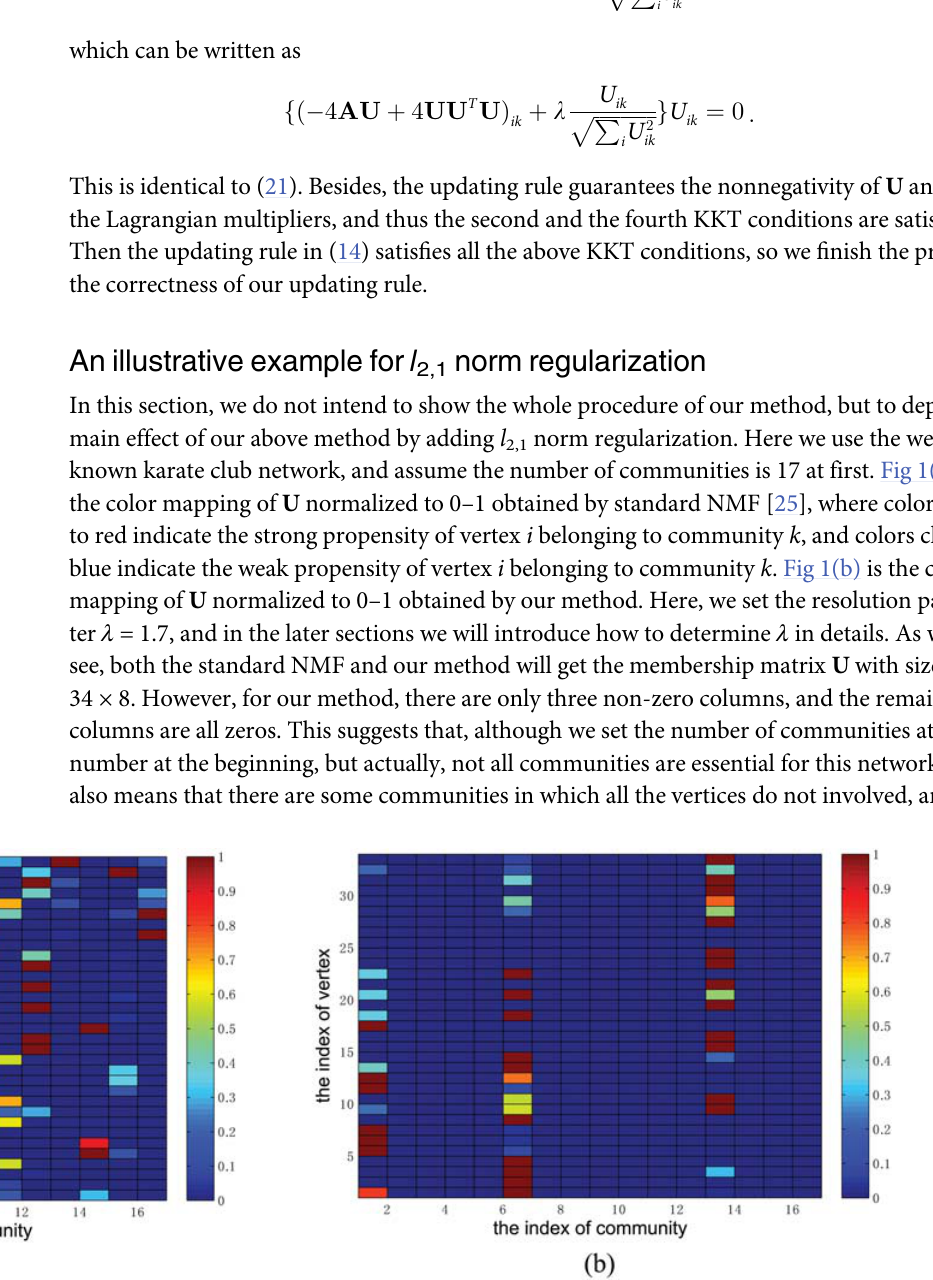
Fig 1. An illustrative example for depicting the main effect of the l 2,1 norm regularization term in our method on karate club network. (a) the color mapping of the membership matrix U obtained by standard NMF. (b) the color mapping of the membership matrix U obtained by our method. X-axis represents the index of community, and Y-axis represents the index of vertex. Colors close to red indicate strong propensity of vertex i belonging to community k .